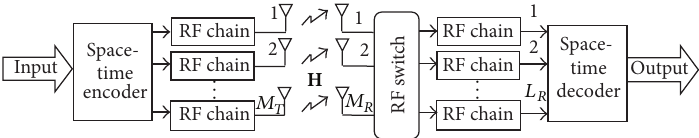
Figure 1: A MIMO system with receive side antenna subset